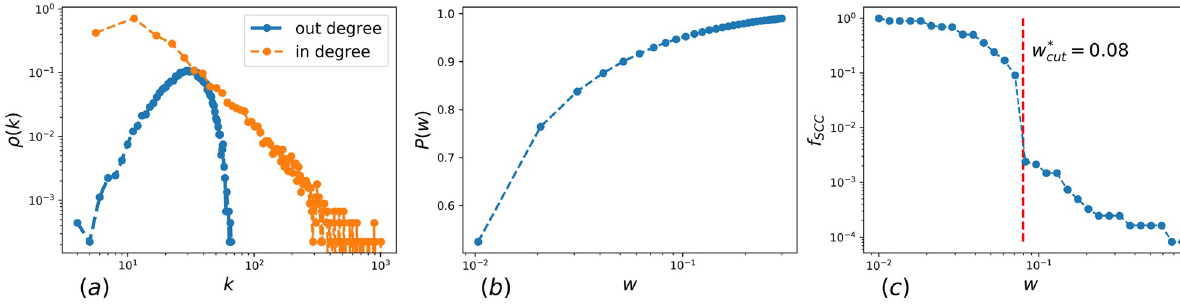
Fig 1. (a) Distributions of in- (blue) and out- (orange) vertex degrees of SWOW-EN; (b) Cumulative distribution of link weights of SWOW-EN; (c) Fraction of nodes in strongly connected component of SWOW-EN in dependence on the link weight cutoff (see [16]).